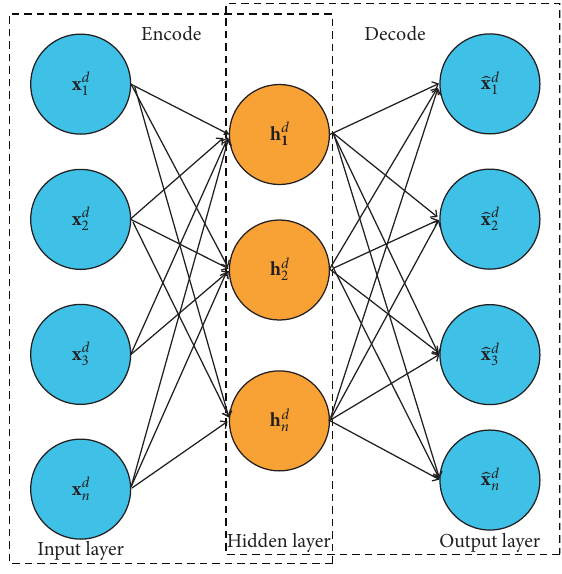
Figure 1: Structure of the basic